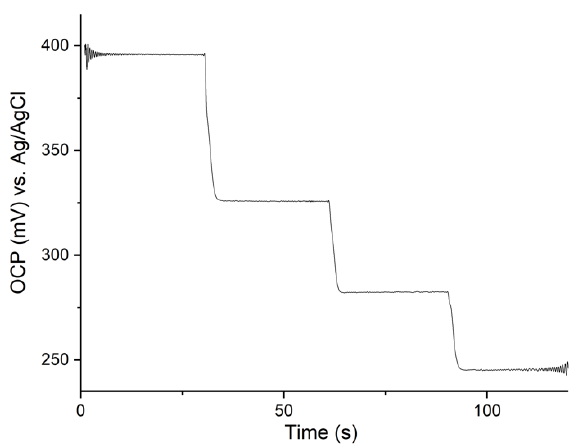
Figure 5. Open-circuit potential recording of the RuOx electrode in changing pH, low-pass filtered with cut-off frequency of ~40 Hz.